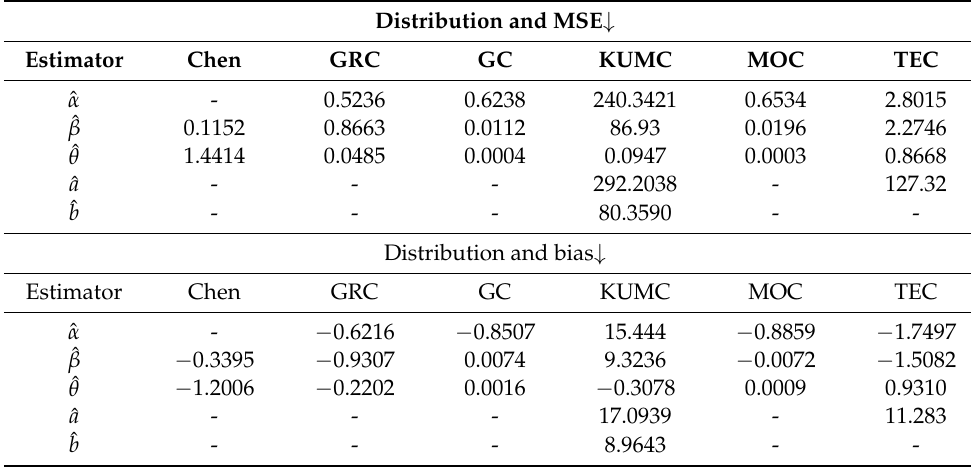
Table 12. Results for samples generated from the Chen distribution with n = 1000.